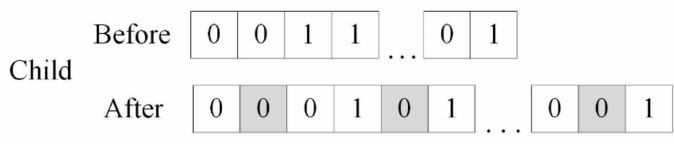
Figure 4. Splicing of the chromosome of the topology